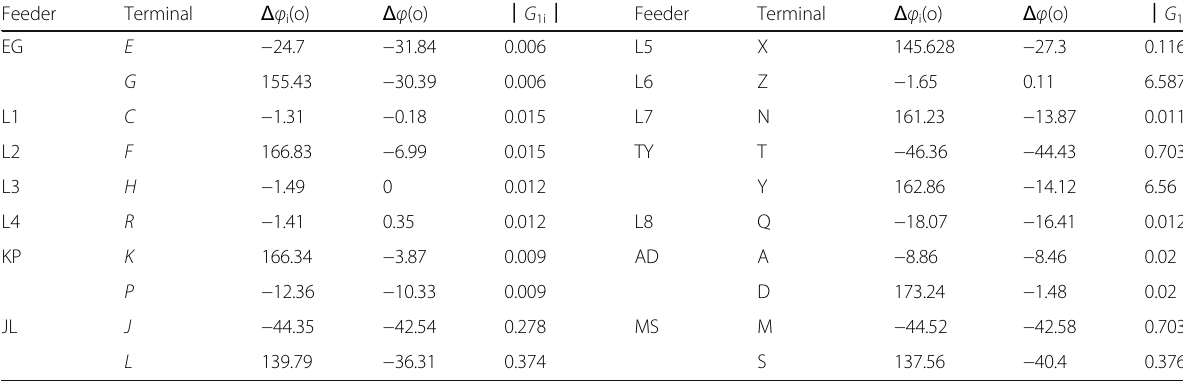
Table 7 Measured admittance results when the F3 fault occurs Feeder